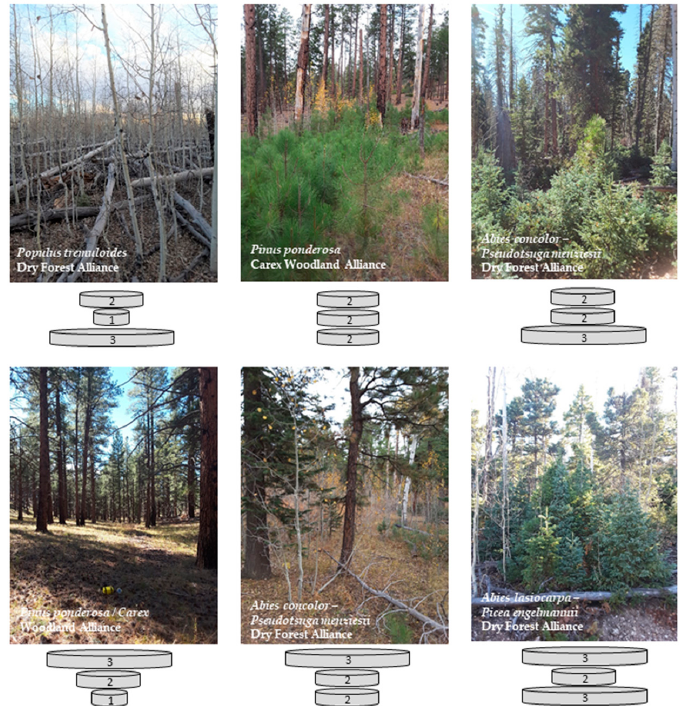
Figure 1. Distributions for 213, 222, 223, 321, 322, and 323. The upper cylinder indicates the canopy cover, the middle cylinder indicates the vertical structure, and the bottom cylinder shows the amount of surface roughness. Photos show examples of structure classes in certain common vegetation types. For example; structure class 213 shows a typical aspen stand, post high-severity fire.